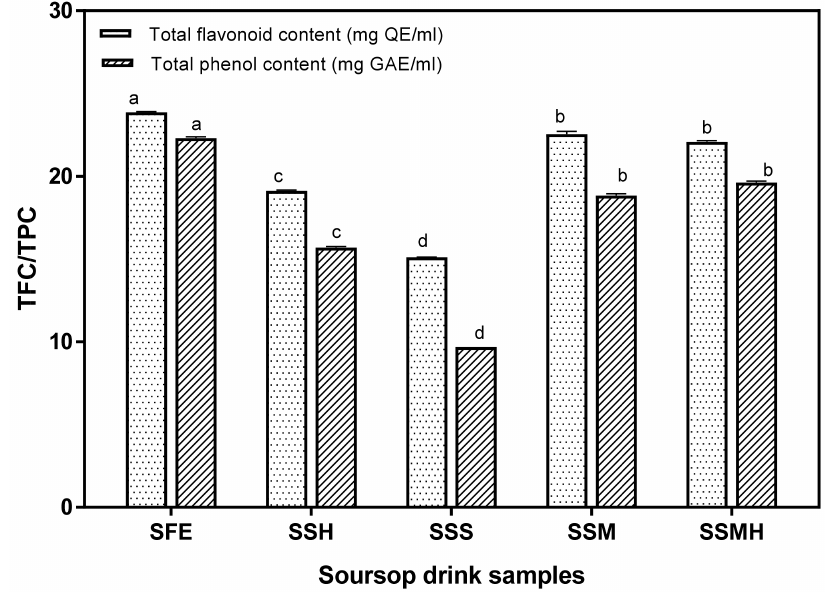
Figure 3. Total flavonoid and total phenolic contents of formulated soursop drinks. Values are means ± SDs; bars with different letters (a–d) are significantly different ( p < 0.05); SFE: soursop fresh extract; SSH: soursop + honey; SSS: soursop + sugar solution; SSM: soursop + milk; SSMH: soursop + milk +